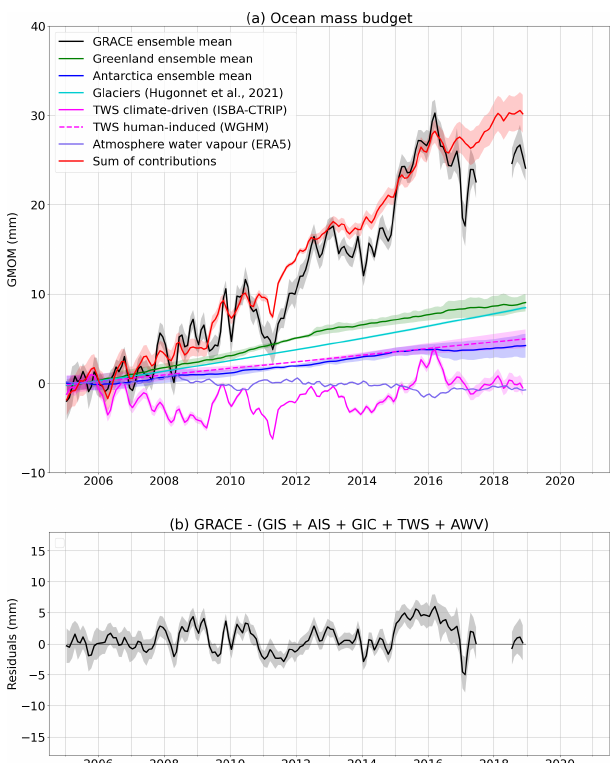
Figure 7. Sea level budget. (a) Budget with GRACE/GRACE-FO- based global mean ocean mass (GMOM) variations compared to altimetry-based GMSL (corrected for the Jason-3 radiometer WTC drift) and Argo-based GMTSL. (b) Budget residuals. Linear trends of all components over different periods of time are provided in Table